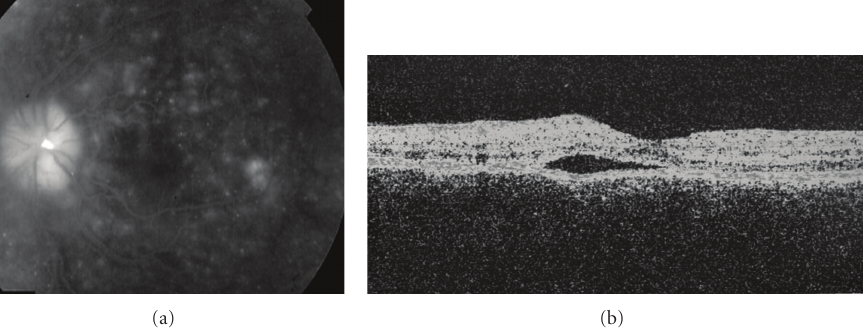
Figure 1: Images of the left eye at presentation. (a) Fluorescein angiography shows multiple, punctate, hyperfluorescent RPE changes and optic nerve hyperfluorescence. (b) Optical coherence tomography shows subretinal fluid in the macula.